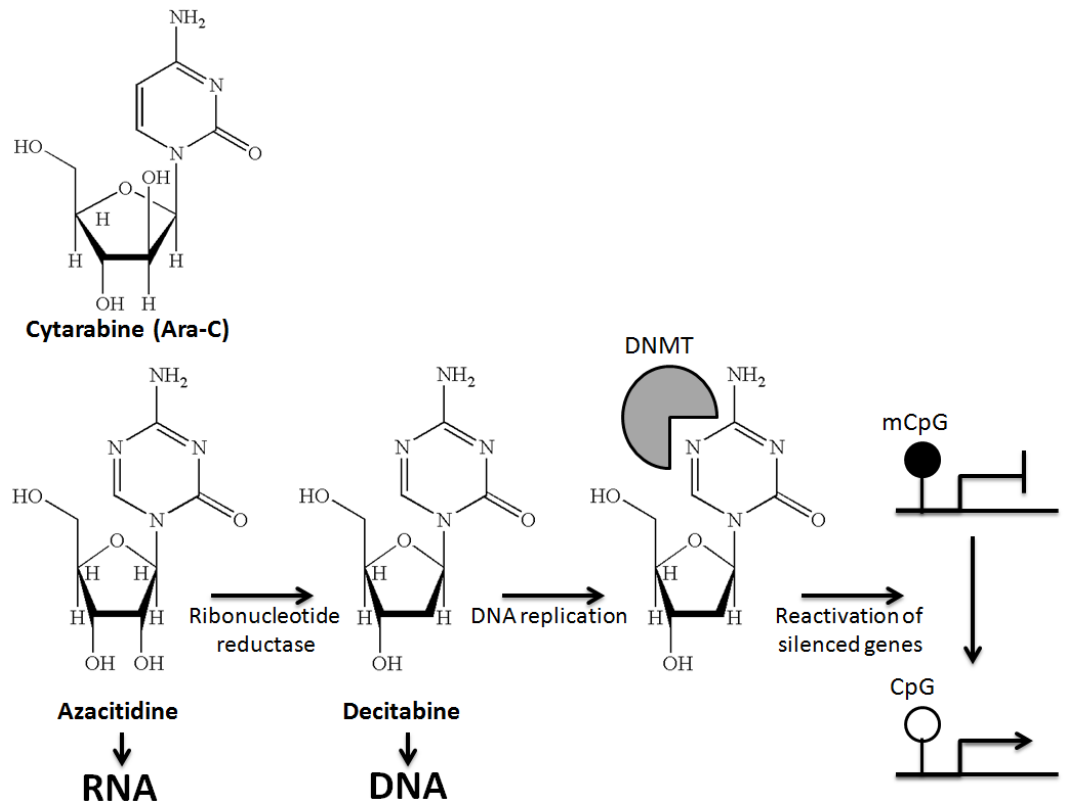
Figure 1. Mechanism of action of hypomethylating agents. (Black circles, methylated CpG; white circles, unmethylated